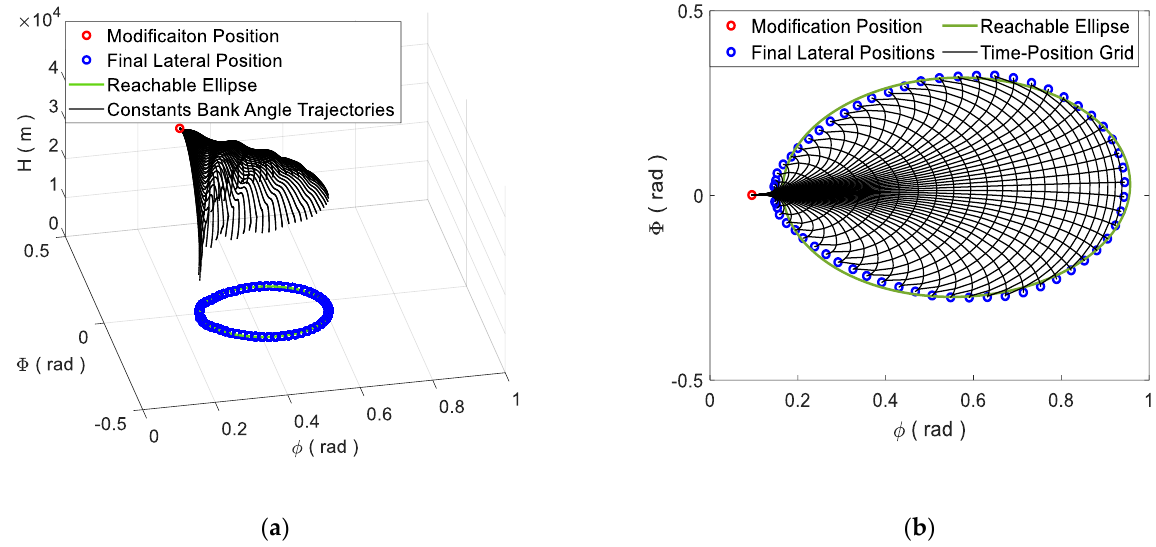
Figure 5. Reachable region and bank angle-time grid: ( a ) represents the reachable region; ( b ) represents the bank angle-time grid.